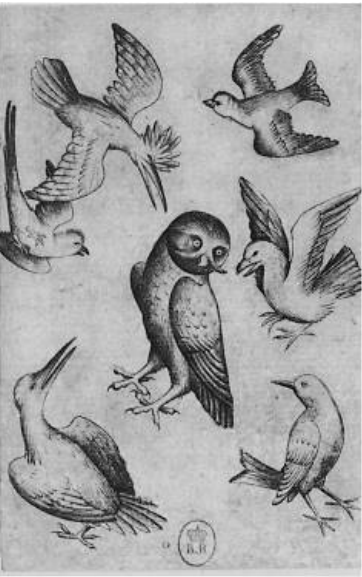
Figure 4. An owl attacked by birds. Master of the Playing Cards, [today’s] southern Germany, first half of the fifteenth century; Paris, Bibliothéque Nationale. Used by permission. Arts 2020 , 9 , x FOR PEER REVIEW